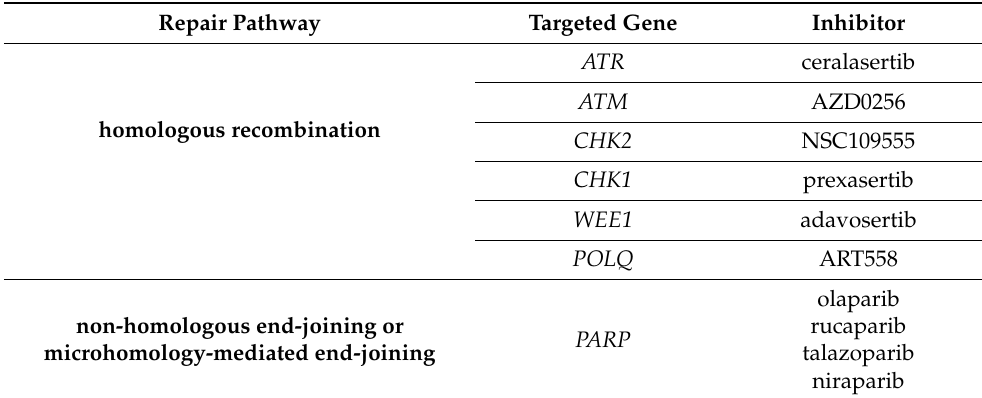
Table 3. Inhibitors targeting DNA damage